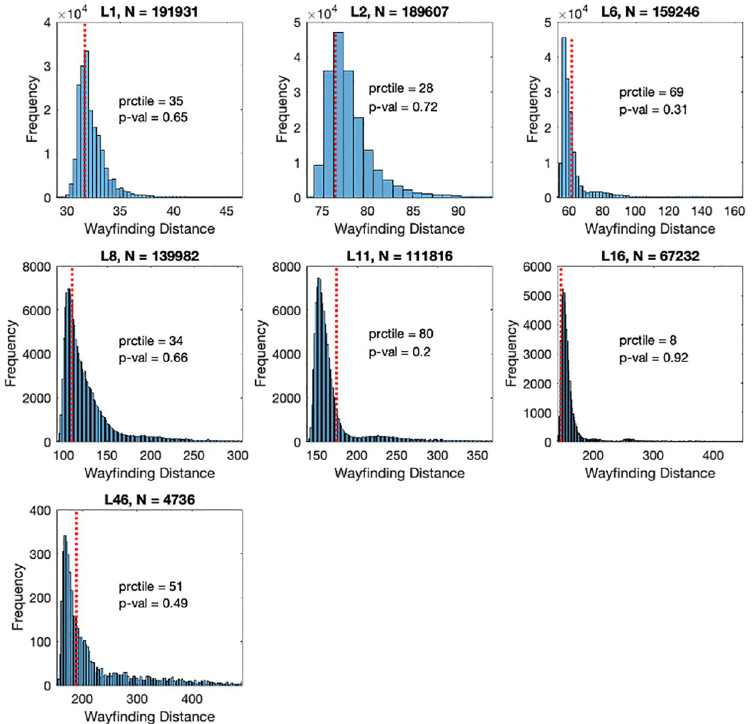
Fig 4. Histogram of distance metrics of patient A individually plotted against distance metrics of control population. ’N’ is the control sample size. The red dashed vertical line corresponds to the patient’s performance. Prctile is the percentile of the patient’s performance in the control distribution. P-value is the inverse (number of controls with worst performance / N).